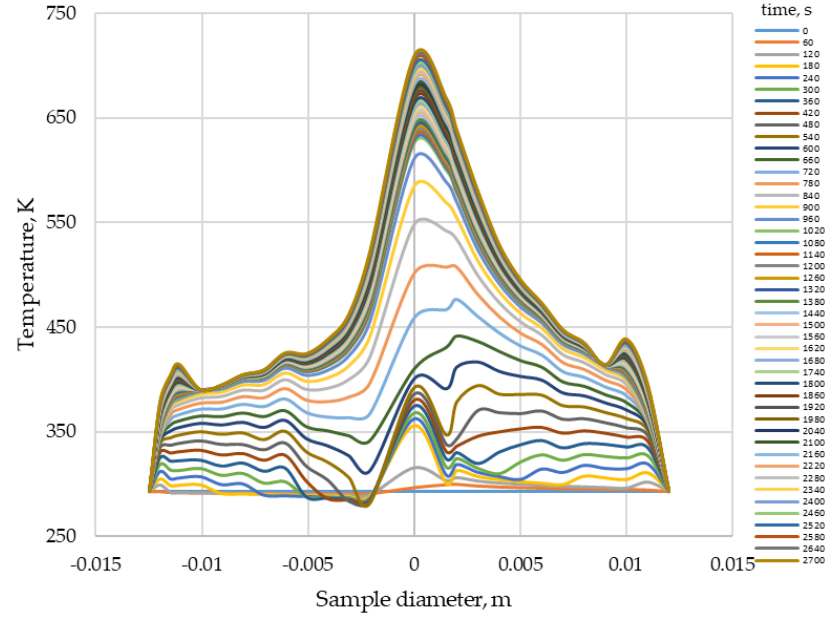
Figure 16. The result of simulation calculations of the temperature distribution along the sample diameter over time.